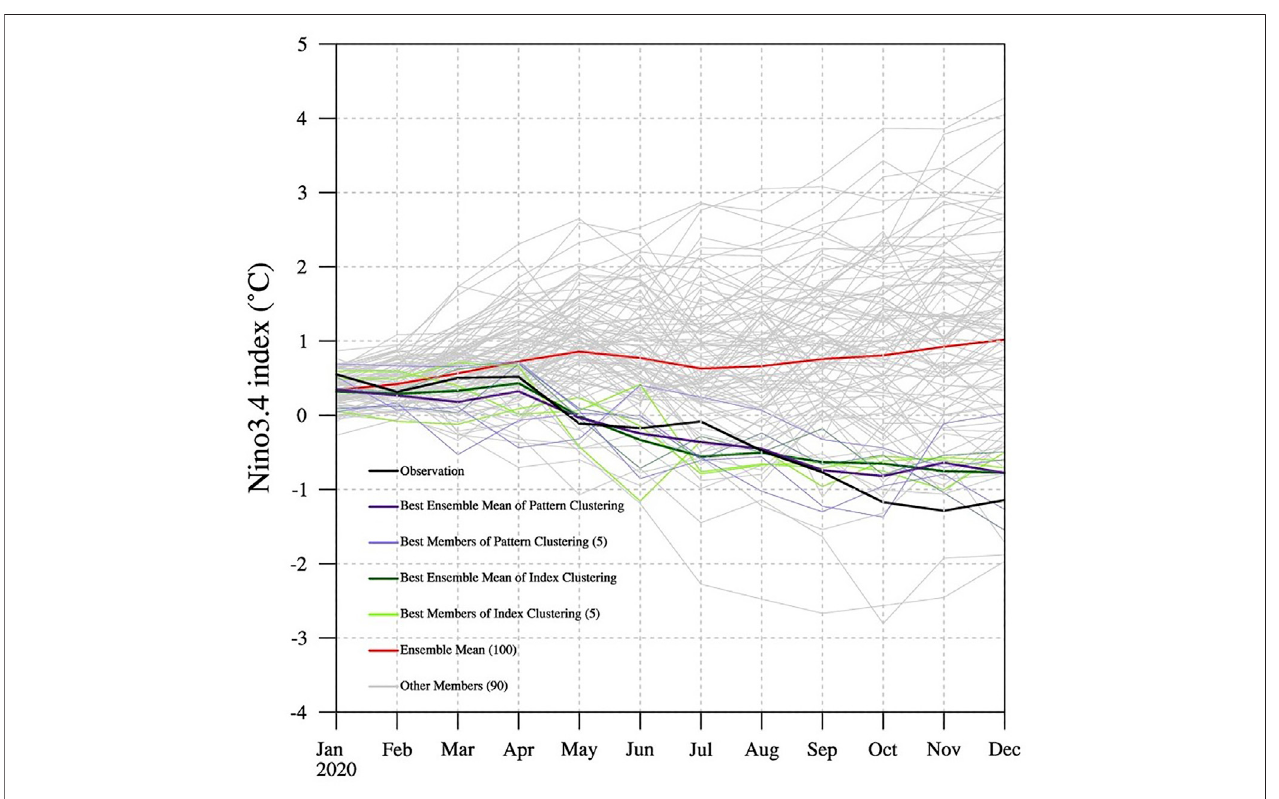
FIGURE 1 | The temporal variation in the Niño3.4 index in 2020 of the observations (black line) and of the best prediction members selected by the two clustering methods. The red line represents the ensemble mean from all 100 ensemble members. The green lines represent the best fi ve ensemble members (light) with the ensemble-mean forecast (dark) selected by index clustering, the purple lines represent the best fi ve ensemble members (light) with the ensemble-mean forecast (dark) selected by pattern clustering, and other gray lines are other residual ensemble members.